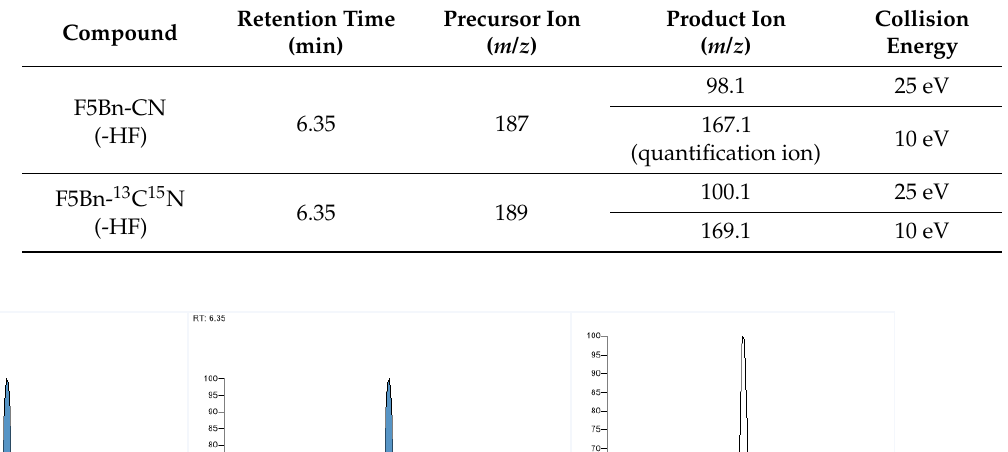
Table 2. Parameters of MS/MS detection for pentafluorobenzyl cyanide natural isotope and isotopically-labelled internal standard.